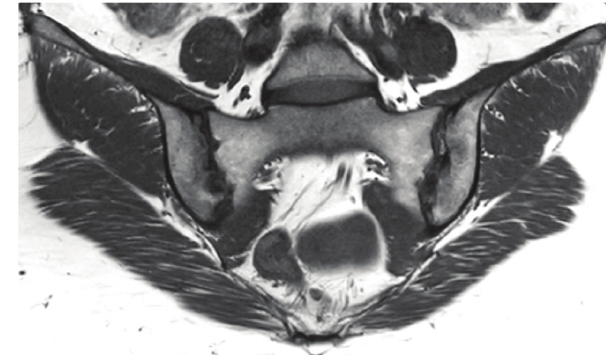
Figure 5: MRI showing multiples subchondral erosions on coronal T1-weighted imaging, predominantly on the right iliac